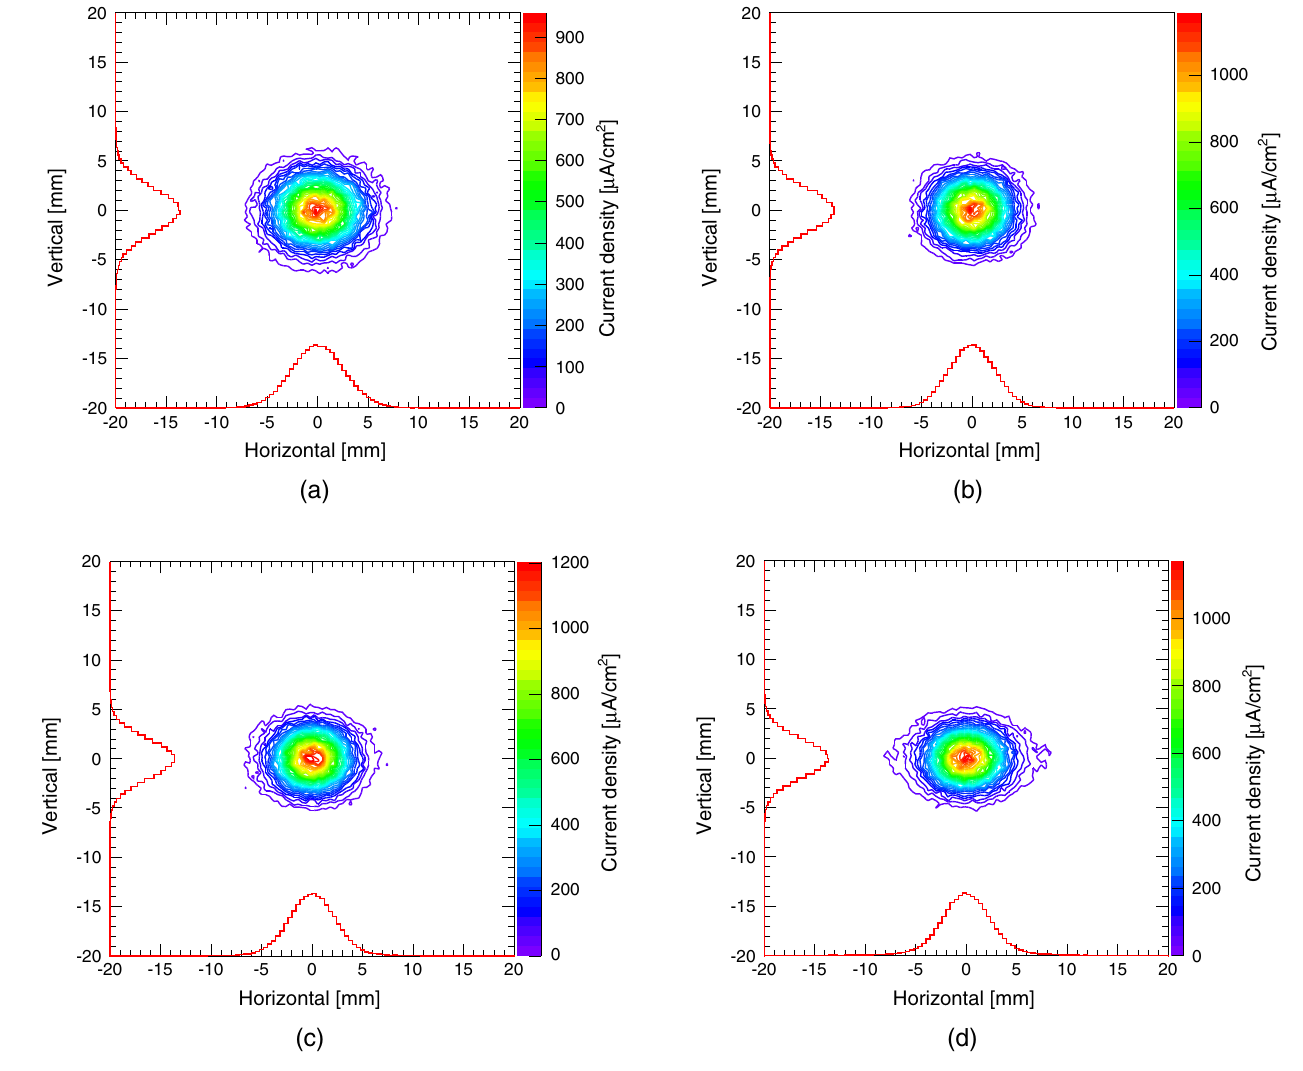
FIG. 17. Calculated beam profile at muon production target for various strengths of octupole magnet. The notations of (a) – (d) are as those in Fig.